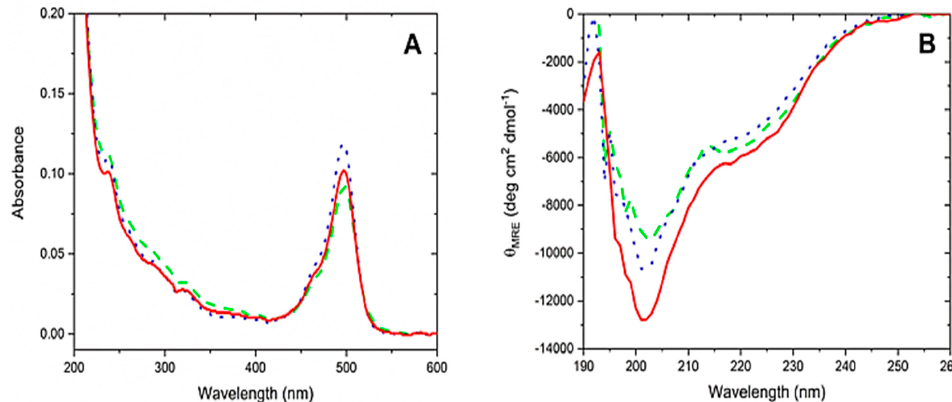
Figure 2. Spectroscopic data for fluorescent conjugates of CGRP in acetonitrile (ACN–High potassium Physiological Saline Solution (KPSS) (1:20, v/v) at 25 °C. ( A ) UV-VIS absorbance used for concentration determination. ( B ) UV-CD (Ultraviolet- Circular Dichroism) spectra for comparison of folding. [N-terminal(Ahx-CF)] h- α -CGRP ( ⎯ ), [Lys 24 (Ahx-CF)] h- α -CGRP (----), [Lys 35 (Ahx-CF)] h- α - CGRP (····).